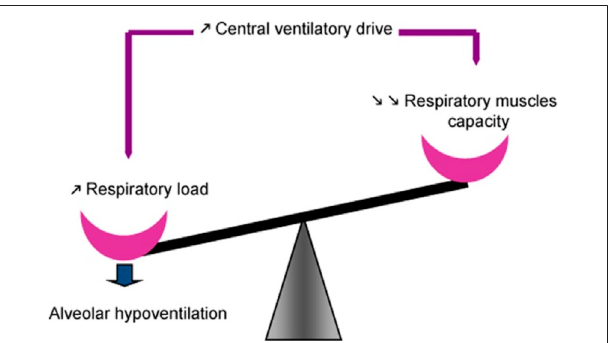
FIGURE3| Respiratorymechanicsinindividualwithmusculardystrophy compared to that of a healthy individual. Shown are the presumed pressure – volume curves of the respiratory system (RS, blue curves) and its two components, the chest wall (CW, green curves) and lung (L, red curves), for healthy subjects (thin curves on the left panel) and patients with muscular dystrophy (thick curves on the right panel). The maximal inspiratory pressure (PImax) is also shown (dashed curves). Key features include 1) decreased total lung capacity (TLC); 2) decreased compliance of chest wall (CCW),lungs(CL)andrespiratorysystem,aconsequenceofreducedthoracic volume (slopes of the corresponding pressure – volume curves); 3) reduced PImax; 4) decreased inspiratory capacity (IC = TLC − FRC); and 5) reduced expiratory reserve volume (ERV = FRC − RV). Functional residual capacity (FRC) may be reduced or even normal. Residual volume (RV) is usually preserved. PImax represents the force of inspiratory muscles, while the volume variations are the resulting action of their contraction. The compliance of the respiratory system is decreased because of (A) lung atelectasis and fi brosis, the former a consequence of hypoventilation, and the latter from recurrent aspirations; and (B) scoliosis, induced by assymmetric involvement of trunk muscles. Figure caption modi fi ed from (Lo Mauro and Aliverti, 2016).